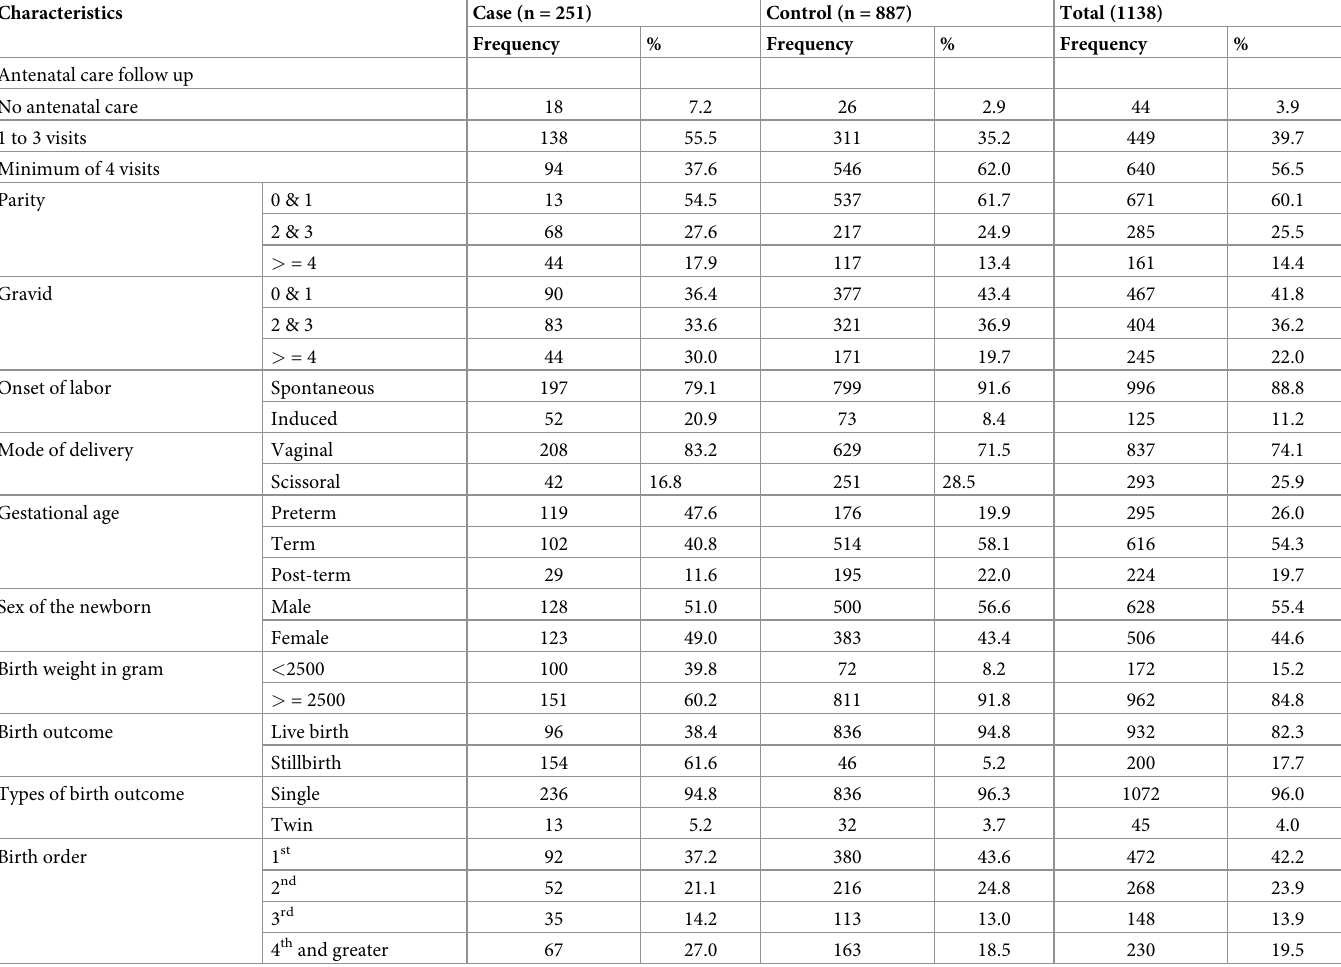
Table 3. Reproductive history of mothers who gave birth to a child with or without CAs in southwestern Ethiopia. Characteristics